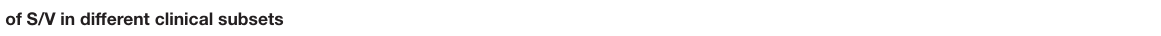
TABLE 2 | Efficacy of S/V in different